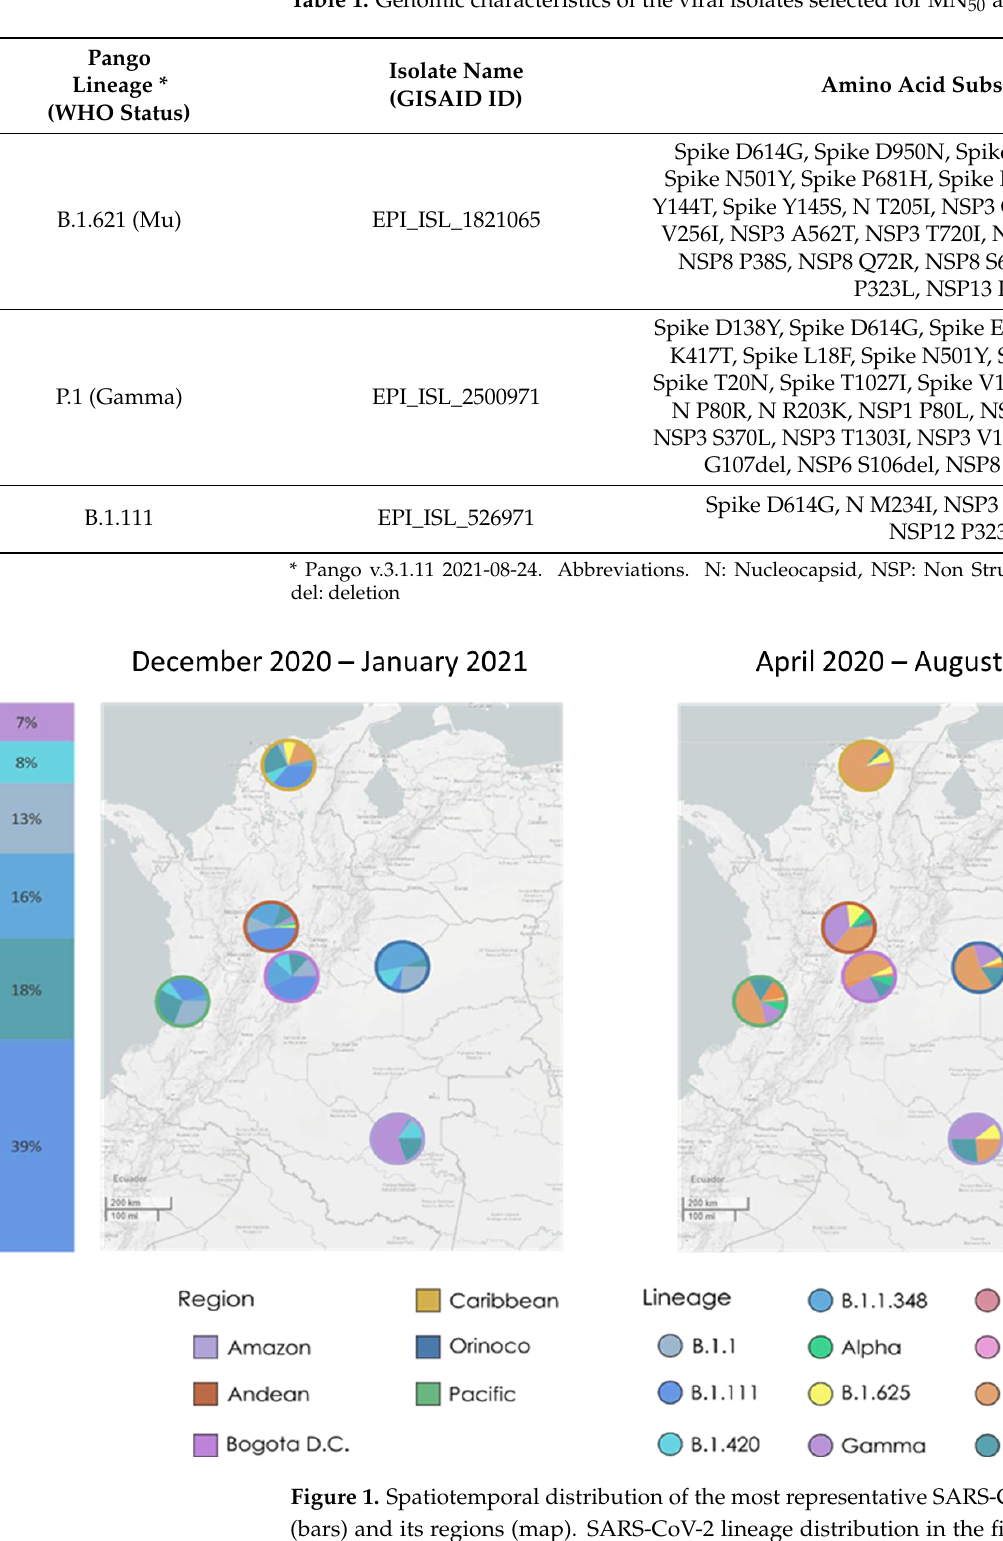
Table 1. Genomic characteristics of the viral isolates selected for MN 50 assays.